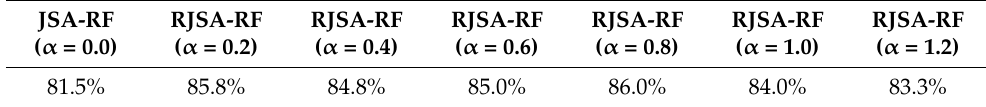
Table 3. Sound classification based on the RJSA features and RF model.